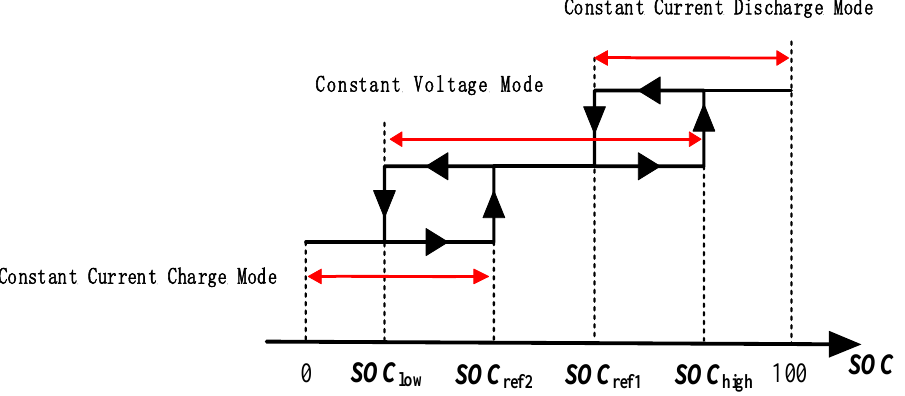
Figure 10. Supercapacitor operating mode hysteresis loop switching diagram. capacitors and maintain the balance of instantaneous power between the system